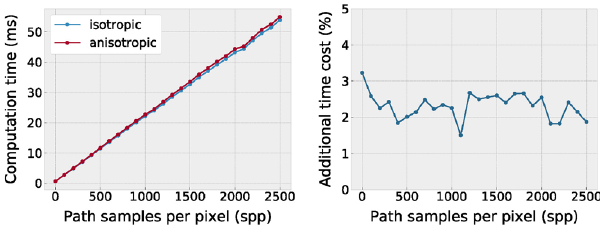
Fig. 5 The chart to the left compares the computation time of Belcour [7] for isotropic BSDFs and our extension to anisotropic BSDFs. The chart to the right shows the additional computation time in percentage terms of our extension over Belcour’s method.